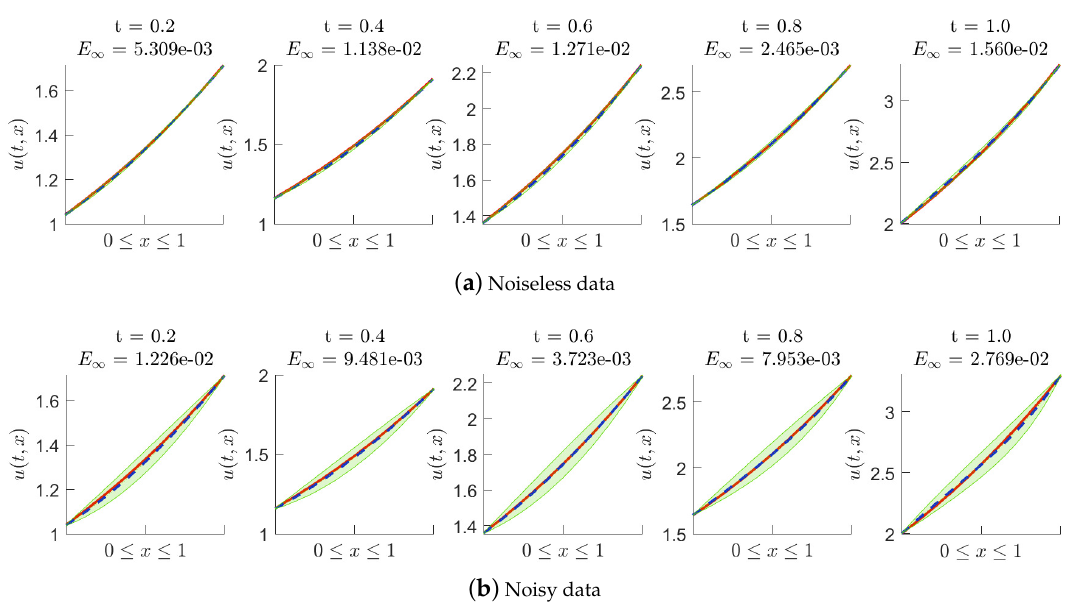
Figure 2. Fractional equation of Example 1: the posterior distribution of the predicted solution at different time nodes, where ( α , β ) is fixed to be ( 0.25,0.75 ) . The red solid line represents the exact solution. The blue dash line represents the posterior mean. The green shade indicates the two posterior standard deviation centered on the posterior mean. Noiseless data and noisy data are used, respectively.